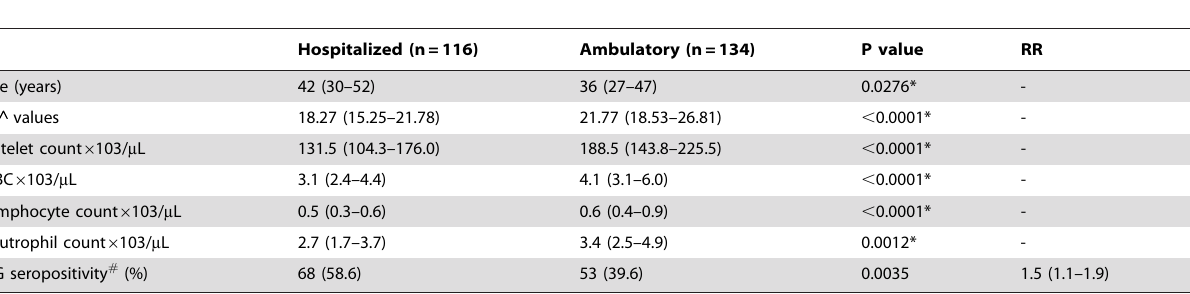
Table 5. Laboratory parameters in dengue patients who received hospitalized or ambulatory care